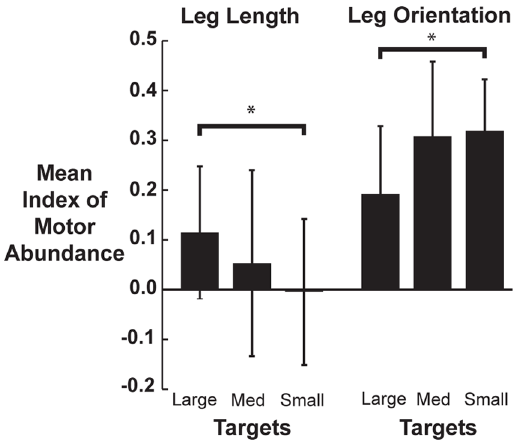
Figure 4. Variance structure as a function of target size. Hop cycle averaged Index of Motor Abundance (IMA) for leg orientation and leg length for the three target conditions. Bars are the averaged IMA across all subjects and bins with 6 1 standard deviation. Average stabilization of leg length decreased from large to small target while leg orientation stabilization increased from large to small target. *denotes significant difference (p , 0.05).